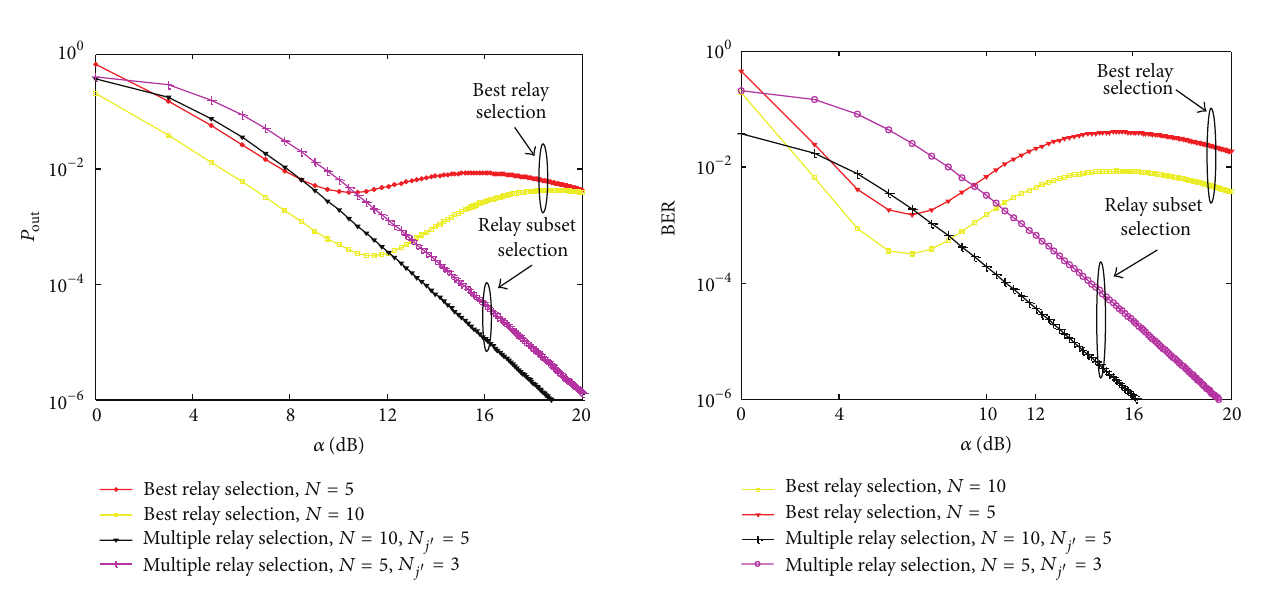
Figure 4: Outage probability with 𝛾 sizes of potential relay network.